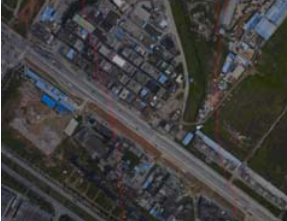
Figure 7. The diagram of the best seamline search based on dynamic programming.